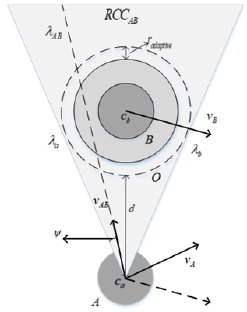
Figure 2. Schematic diagram of adaptive speed